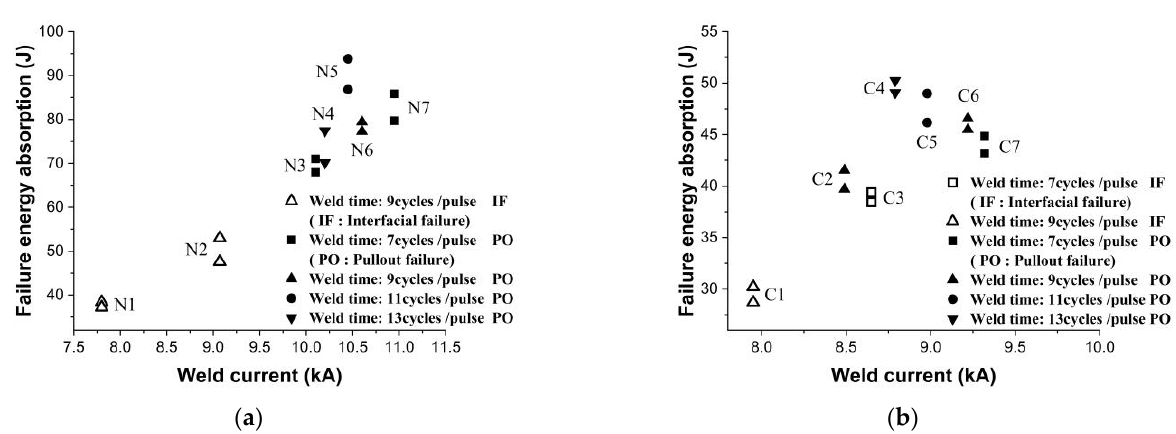
Figure 9. Failure energy absorption of welded joints for ( a ) uncoated hot-stamped Usibor1500 and ( b ) Al-Si coated hot-stamped Usibor1500.